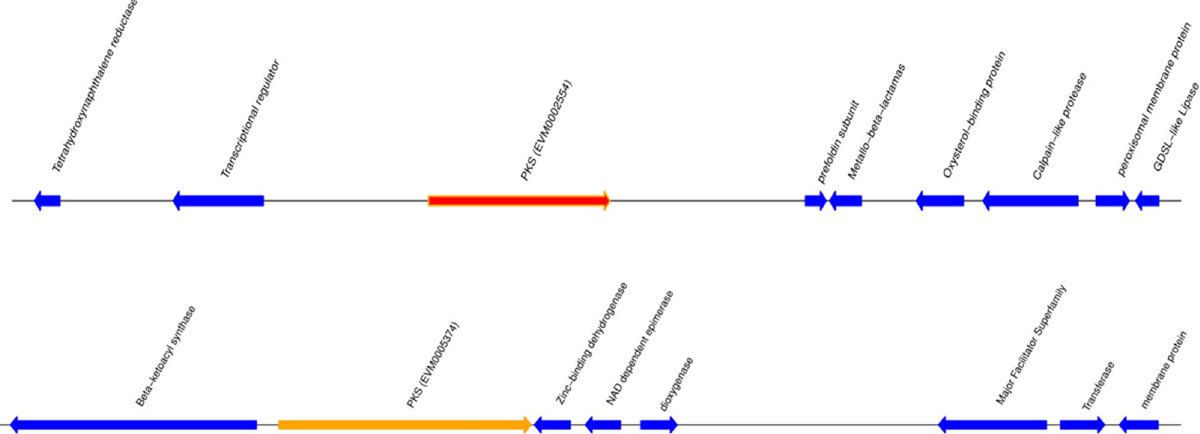
Figure 6. Pigment gene cluster. Red represents pigment genes, blue represents other genes in the cluster and the forward arrow points to the